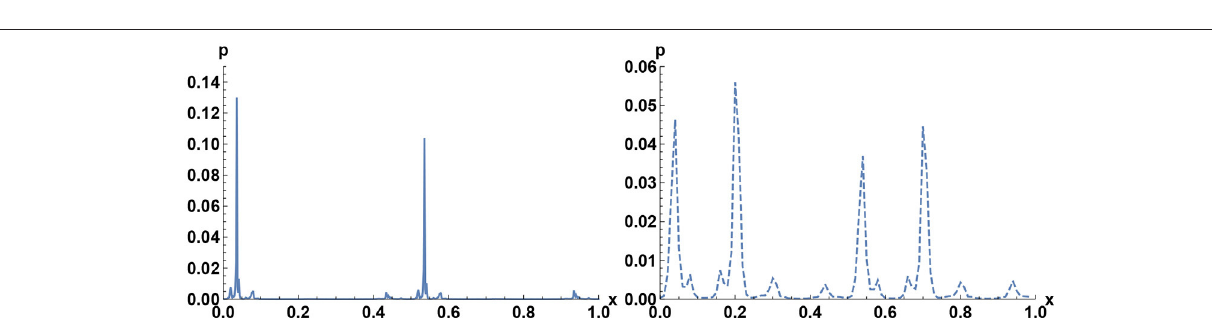
FIGURE 5 | The numerical results for probability distribution of x = α/ (2 π ), q 01 = q 10 = 0.20. (Left) The smooth line is ρ 0 ( x ), and (Right) the dashed line ρ 1 ( x ).